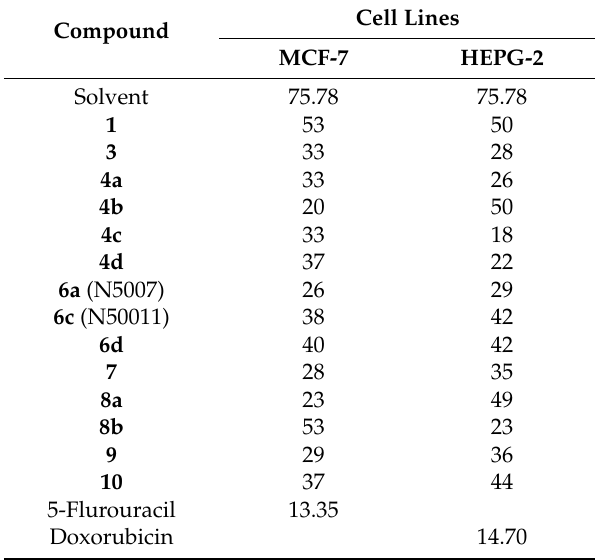
Table 1. IC 50 of the newly synthesized products against the two cell lines. Cell Compound